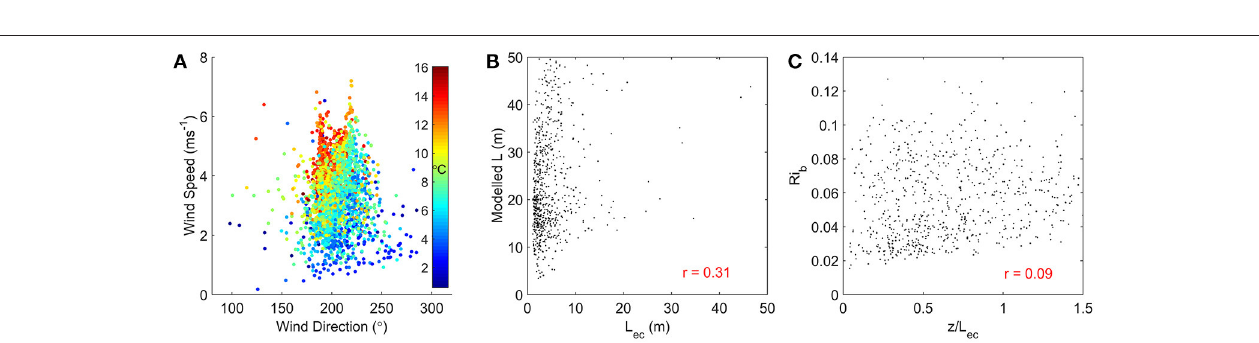
FIGURE 8 | (A) Distribution of the EC-derived scalar roughness length values (overlapping regions in purple), and the relationships between the roughness Reynolds number and the (B) z 0 t / z 0 v and (C) z 0 q / z 0 v ratios, as proposed by Andreas (1987), and Smeets and van den Broeke (SvdB) (2008), and as observed in this study (during near-neutral conditions).